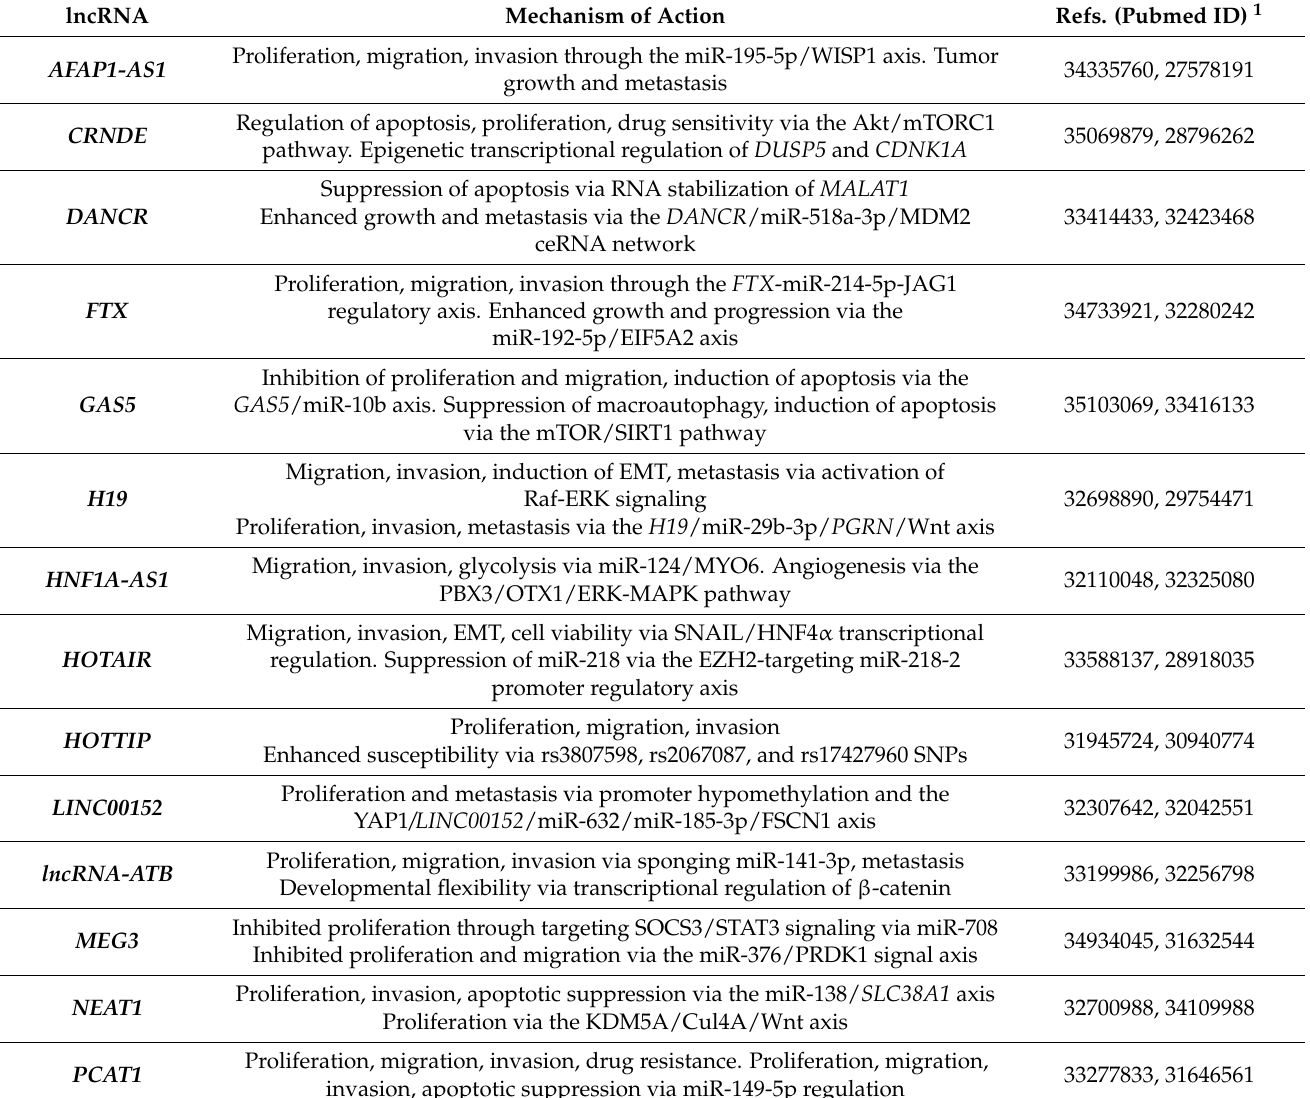
Table 2. LncRNA candidates with strong supporting evidence for a regulatory role in